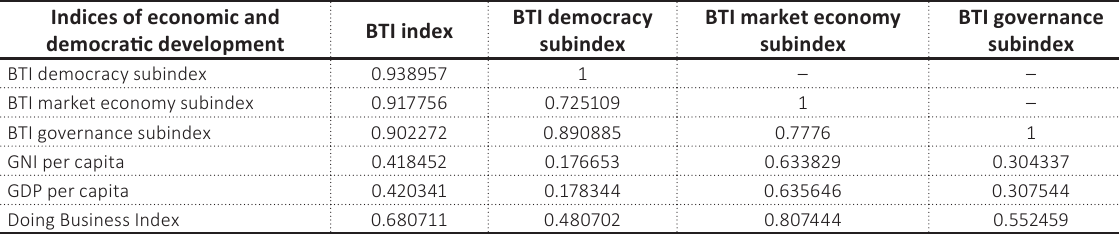
Table 1. Matrix of cross-correlation between economic development and favorability of the business